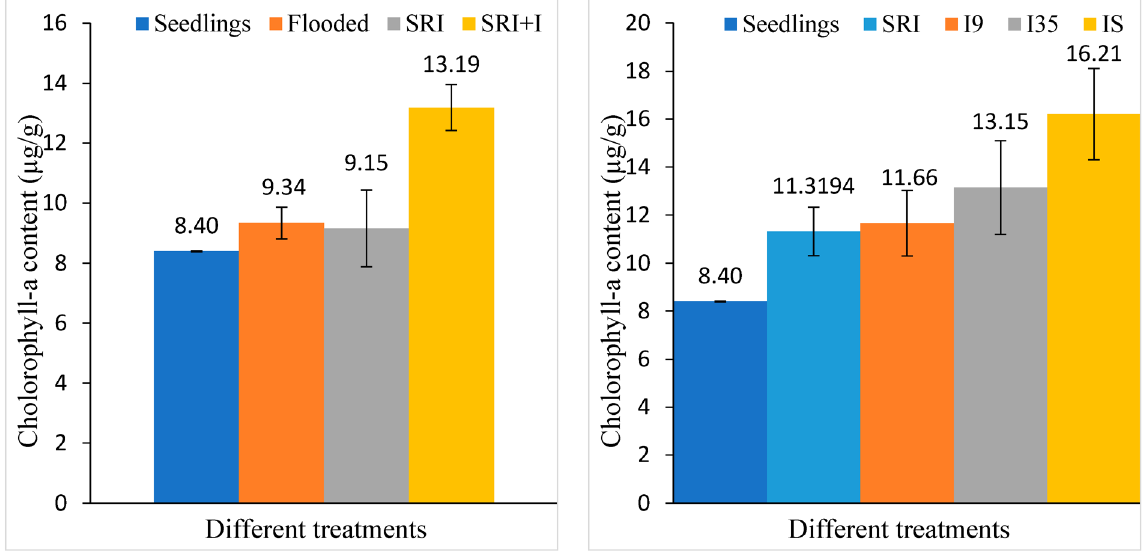
Figure 12. Comparison of chlorophyll-a content between the different treatments ( Left : 2017; Right : 2018).